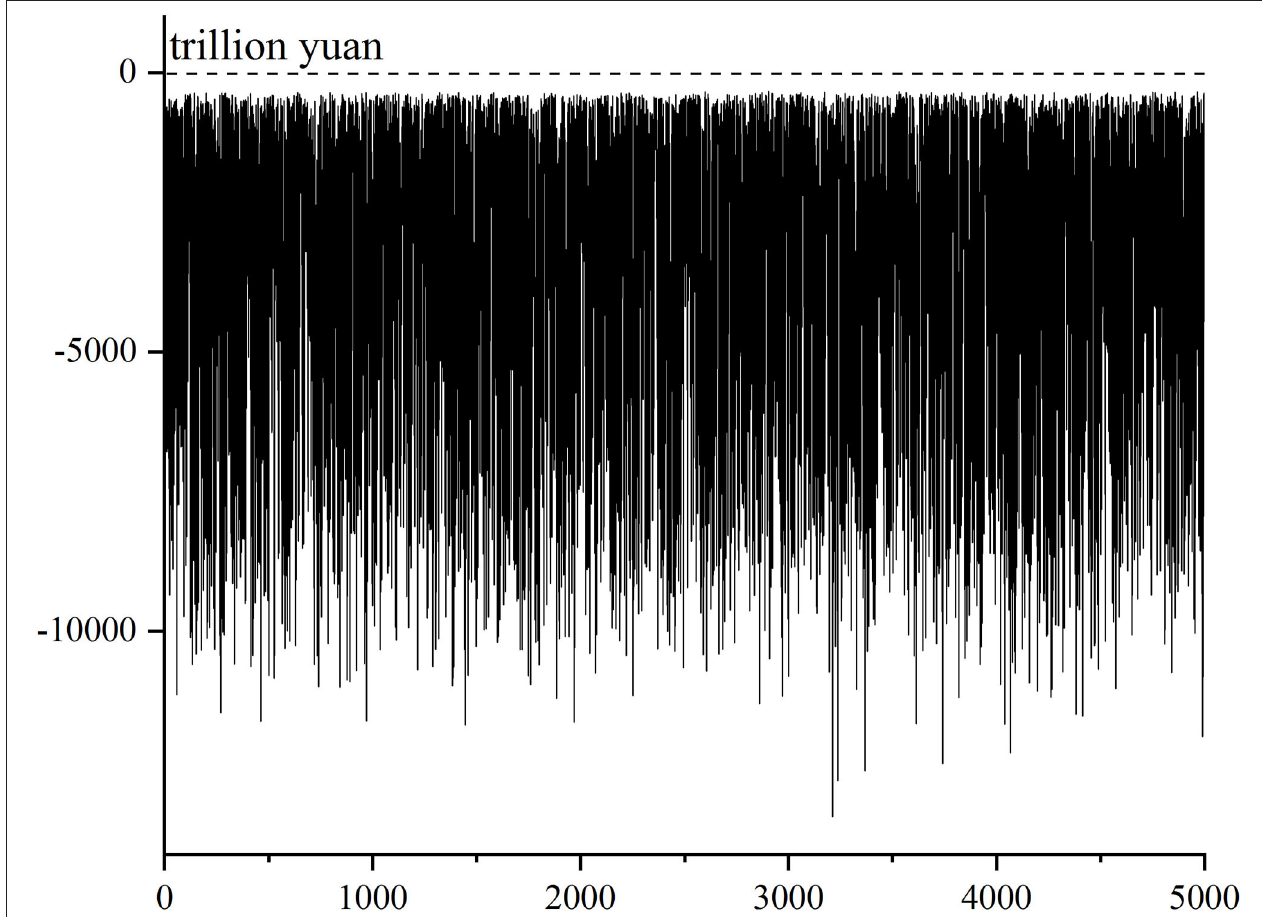
FIGURE 4 | Distribution of the final fund reserve status of basic pension